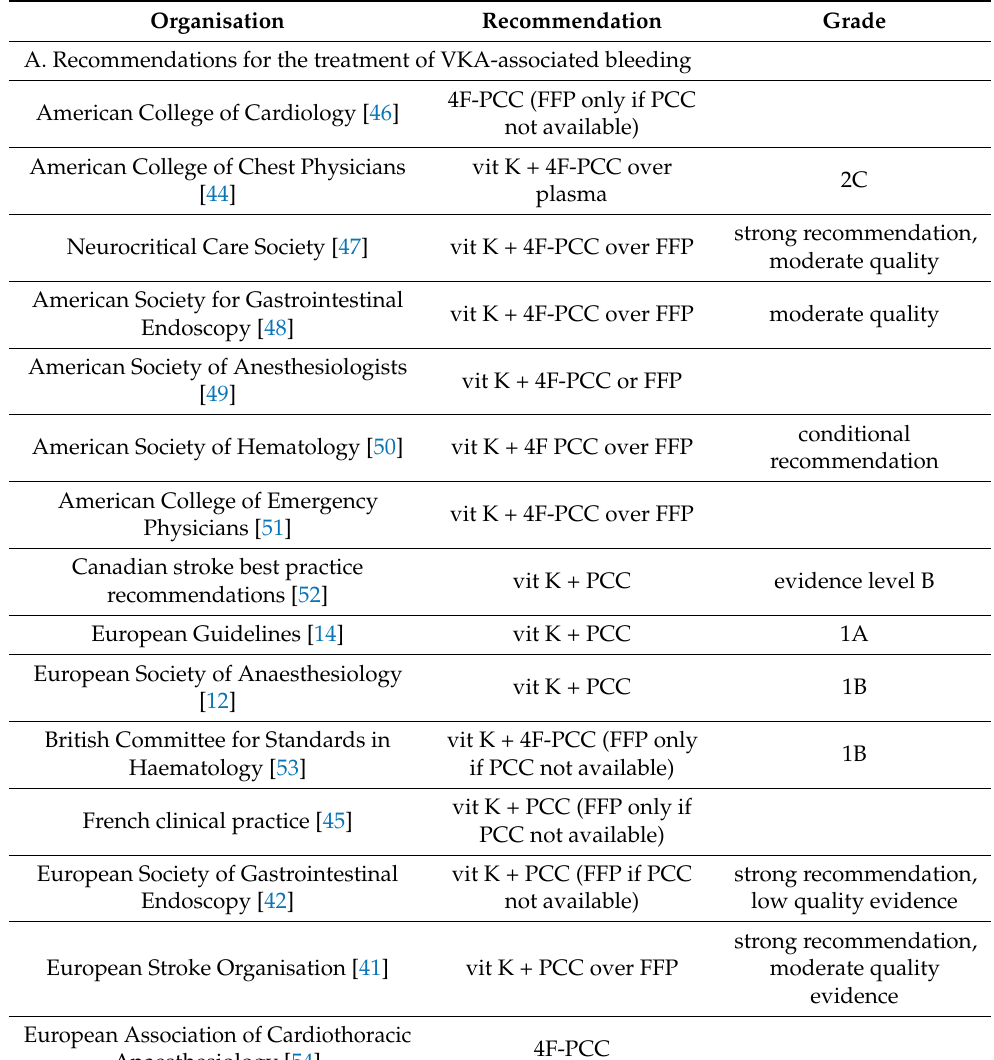
Table 1. Summary of guideline recommendations for the treatment of bleeding related to VKA and